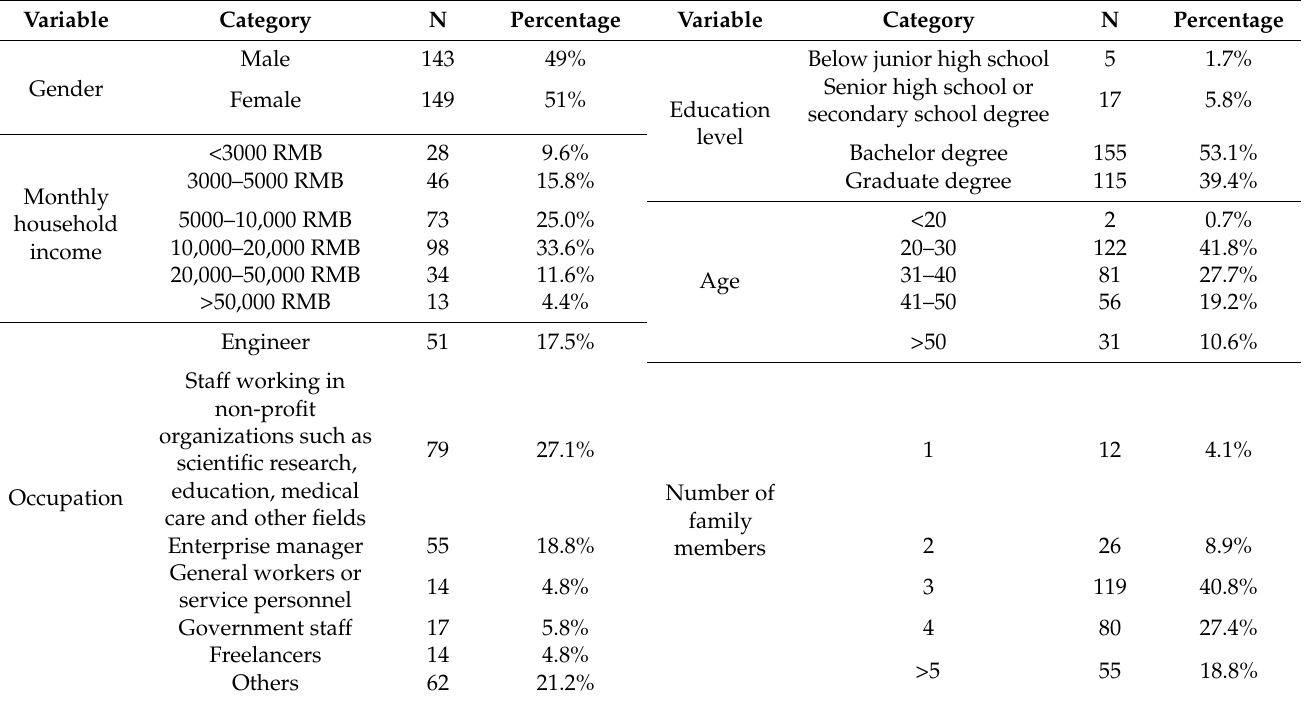
Table 1. Participant’s Descriptive Statistical Analysis